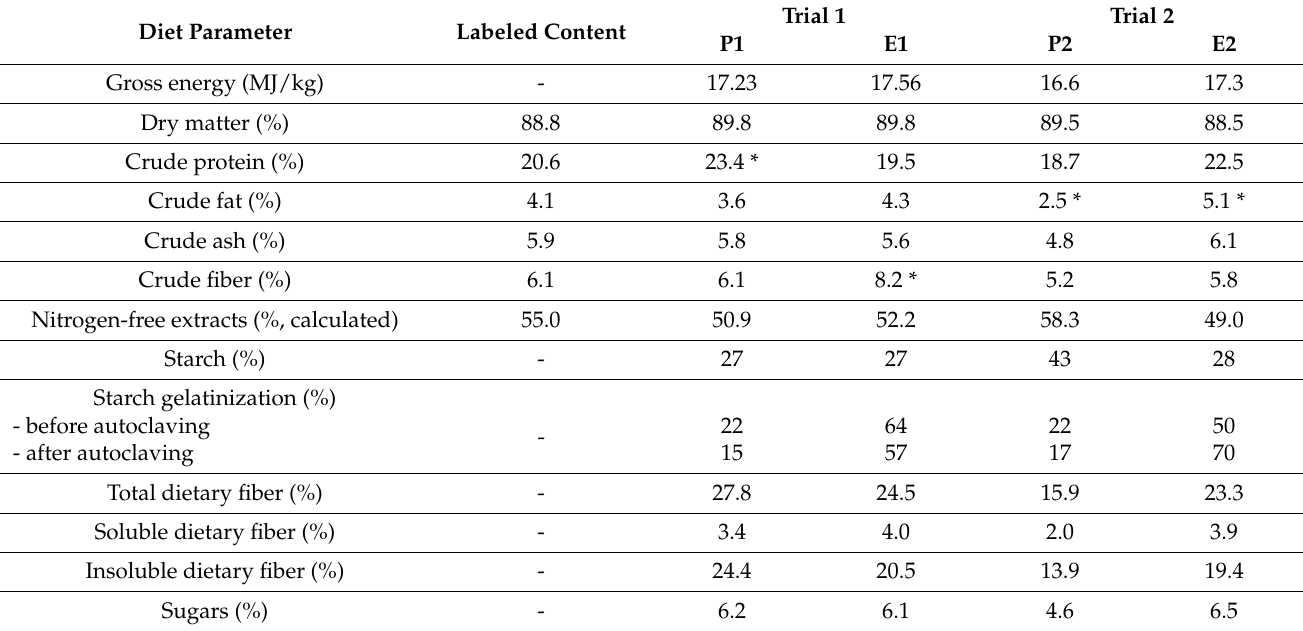
Table 1. Energy and nutrient contents and degrees of starch gelatinization for the diets used in both trials 1 and 2 in the pelleted (P) and extruded (E)